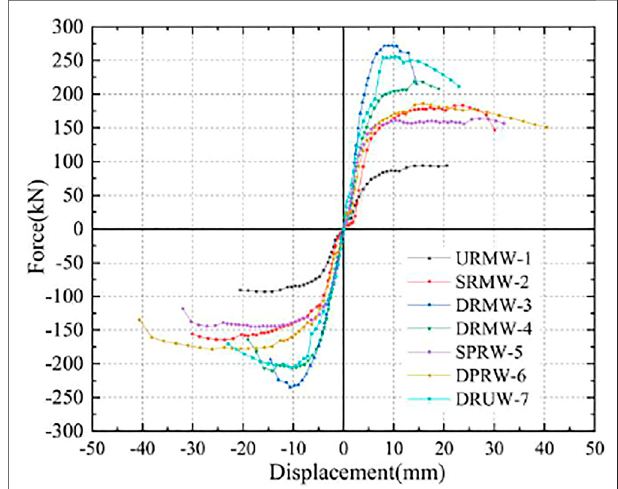
FIGURE 11 | Skeleton curves of